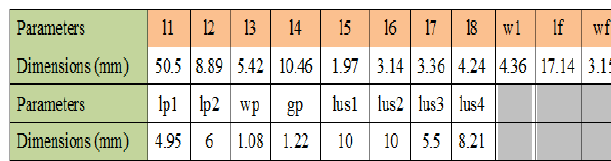
Figure 4. Design steps of proposed quadruple-band microstrip antenna. Table 1: Dimensions of the proposed quadruple-band microstrip